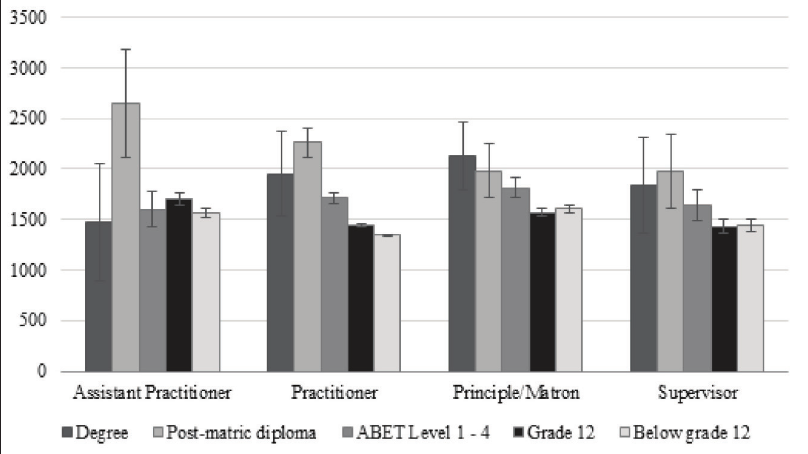
Figure 6: Average monthly salary by level of qualification (in Rand), 2013 (Source: